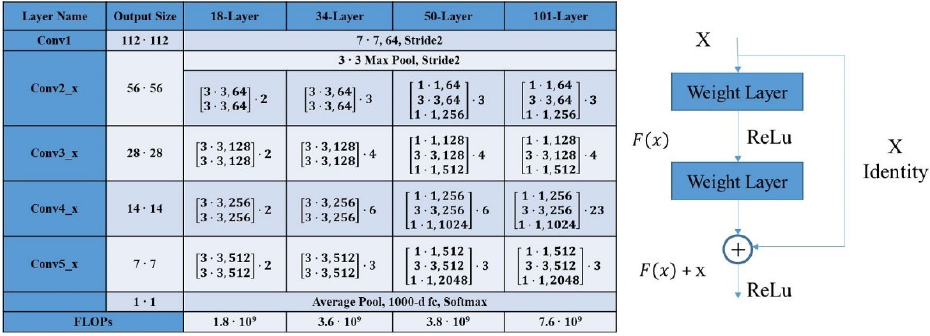
Figure 2. Architectures for ImageNet and Residual Learning: a building block.